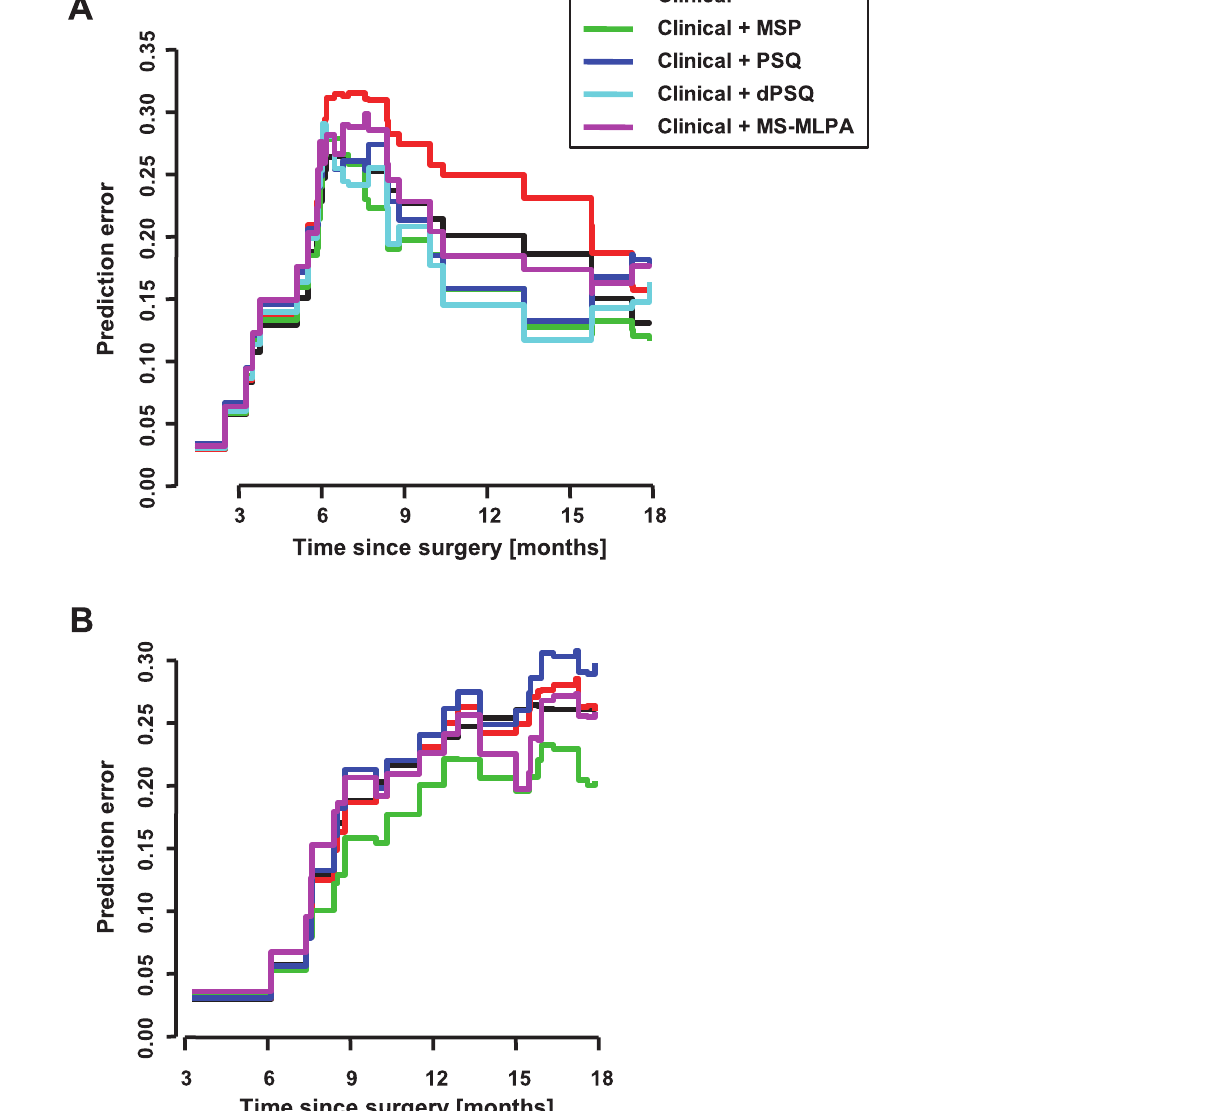
Figure 3. Prediction error curves for each diagnostic method with respect to (A) PFS and (B) OS. To assess the predictive accuracy of models including methylation data, the cumulating prediction error curves over 18 months follow-up time and a time-dependent R 2 -like measure were computed for the marginal Kaplan-Meier estimates (Kaplan-Meier), the Cox model using clinical data only (i.e., age, gender, Karnofsky performance status, extent of resection [Clinical]), and the Cox model using combined clinical plus methylation data as determined by MSP (Clinical + MSP), PSQ CpG sites 1 to 5 (Clinical + PSQ), dichotomised PSQ CpG sites 1 to 5 (Clinical + dPSQ), and MS-MLPA sites 1 to 3 (Clinical + MS-MLPA). Prediction error curves for dichotomised methylation data at MS-MLPA sites 1 to 3 (PFS and OS) and pyrosequencing CpG sites 1 to 5 (OS) were not feasible due to insignificant cut-points (see Table 2).